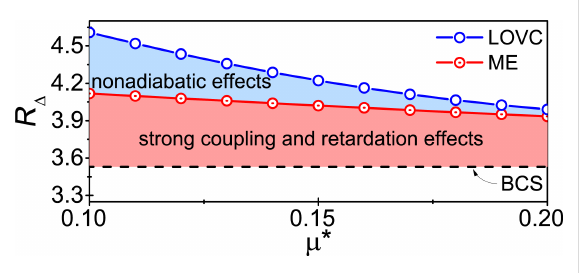
Figure 2: The values of the ratio R Δ as a function of the Coulomb pseudopotential. The results obtained under the model: LOVC, ME, and